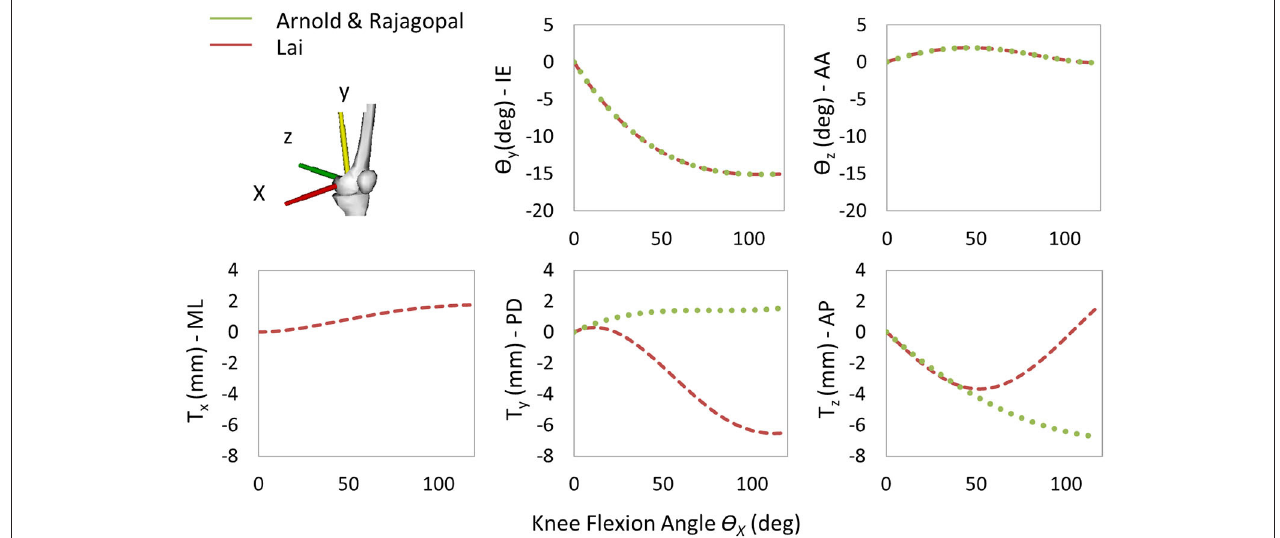
FIGURE 1 | Trends of the coupled translations and rotations of the tibia with respect to the femur as a function of the knee flexion angle for the three models. Only one curve is reported for Arnold and Rajagopal since the same knee spline functions are implemented in the models. models, each scaled to fit the patient of the Fifth Knee Grand Challenge (KGC) (Fregly et al.,